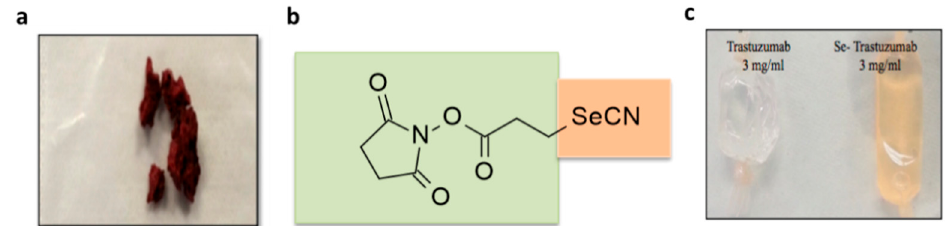
Figure 2. ( a ) Se-BHR: selenium conjugating Bolton–Reagent; ( b ) chemical structure of Se-BHR; ( c ) control and selenium labeled Tz following exhaustive dialysis, pH 7.4.